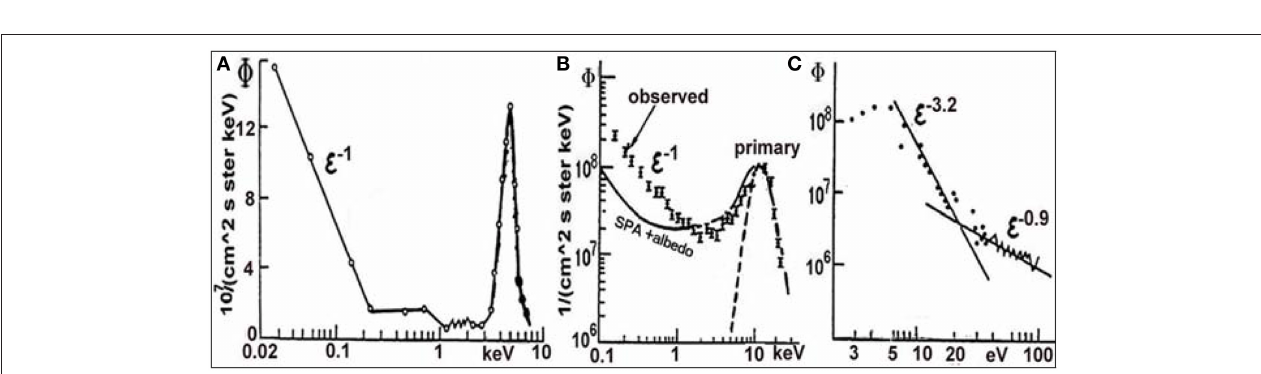
FIGURE 12 | (A) The different stationary BPD regimes vs. altitude defined by the beam relaxation regimes. Adapted from Mishin and Ruzhin (1980a). (B) Altitude and neutral density range over which BPD is expected. The first stripped column indicates the range expected from Mishin and Ruzhin’s analysis. The second stripped column indicates the parameter range over which BPD has been observed in the large tank at the Jonson Space Center. The vertical line on the right indicates the altitude range over which the EXCEDE and PRECEDE experiments with currents far beyond the BPD thereshold were conducted. Adapted from Linson (1982). Reprinted by permission from Plenum Press.